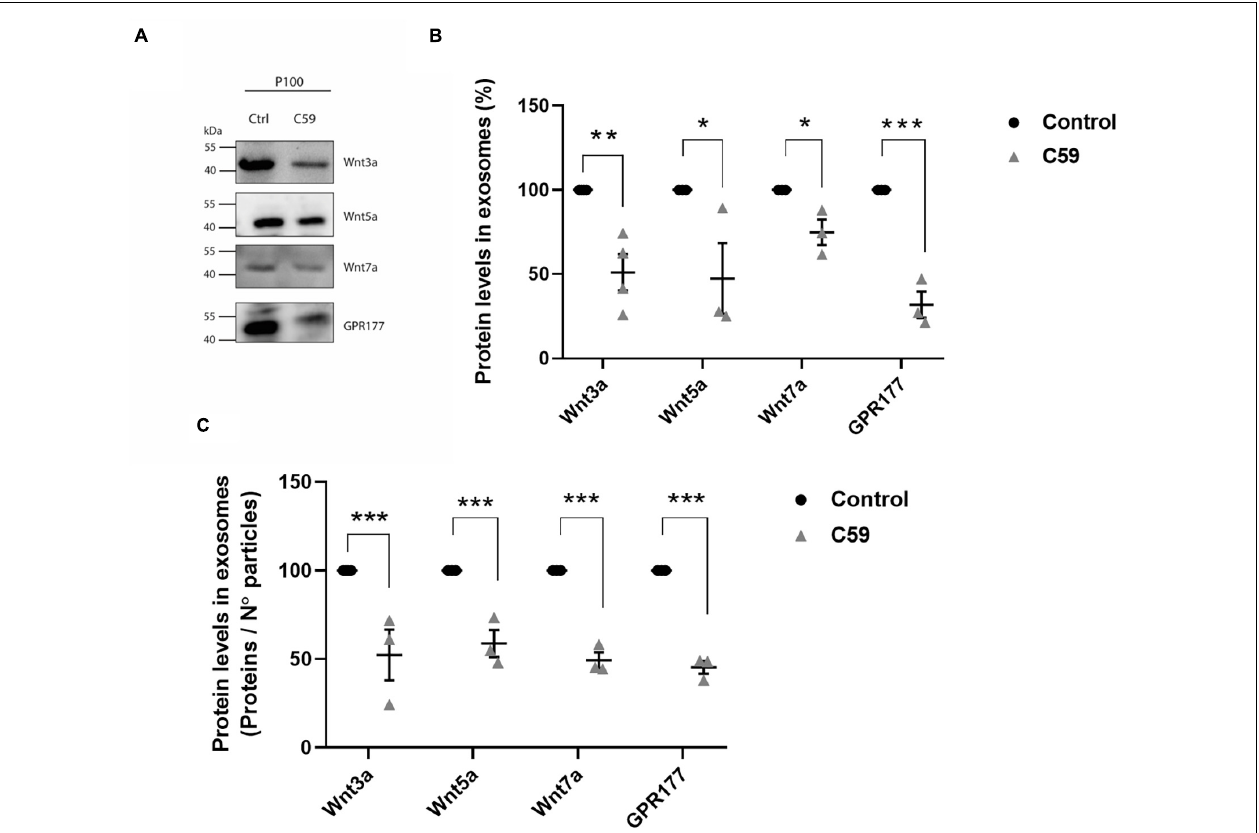
FIGURE 5 | Effects of Wnt-C59 on the content of Wnt ligands in the P100 fraction. (A) Comparison of the western blot analysis of Wnt3a, Wnt5a, Wnt7a, and GPR177 protein expression levels in the P100 fraction derived from control and Wnt-C59 treated cells (each lane was loaded with 30 µ g protein). (B) Relative protein expression levels of Wnt ligands and GPR177 in the P100 fraction. The staining intensity of each band derived from control P100 was assigned a value of 100%, and the value obtained in the P100 from Wnt-C59 treatment was compared with its respective control. Wnt3a (Control: 100%, Wnt-C59: 51.1 ± 21.5%; n = 3; p = 0.0039); Wnt5a (Control: 100%, Wnt-C59: 39.1 ± 45.6%; n = 3; p = 0.0404); Wnt7a (Control: 100%, Wnt-C59: 74.82 ± 13.1%; n = 3; p = 0.0291); GPR177 (Control: 100%, Wnt-C59: 31.9 ± 13.6%; n = 3; p = 0.001). (C) Protein expression levels of Wnt ligands and GPR177 relative to the number of particles loaded per well. Control P100 was assigned a value of 100%, and the value obtained in the P100 from Wnt-C59 treatment was compared with its respective control. In both types of analysis of (B,C) , the Wnt3a, Wnt5a, Wnt7a, and GPR177 contents significantly decreased in the exosomes secreted by Wnt-C59 treated cells relative to their levels in the control cells based on the results of Mann–Whitney non-parametric t -student test (ns, not significant; * p < 0.05; ** p < 0.01; *** p < 0.005). Wnt3a (Control: 100%, Wnt-C59: 52.4 ± 24.9%; n = 3; p = 0.0295); Wnt5a (Control: 100%, Wnt-C59: 58.8 ± 13.2%; n = 3; p = 0.0056); Wnt7a (Control: 100%, Wnt-C59: 49.4 ± 7.8%; n = 3; p = 0.0004); GPR177 (Control: 100%, Wnt-C59: 45.3 ± 6.2%; n = 3; p = 0.0001). n value means the number independent cell culture